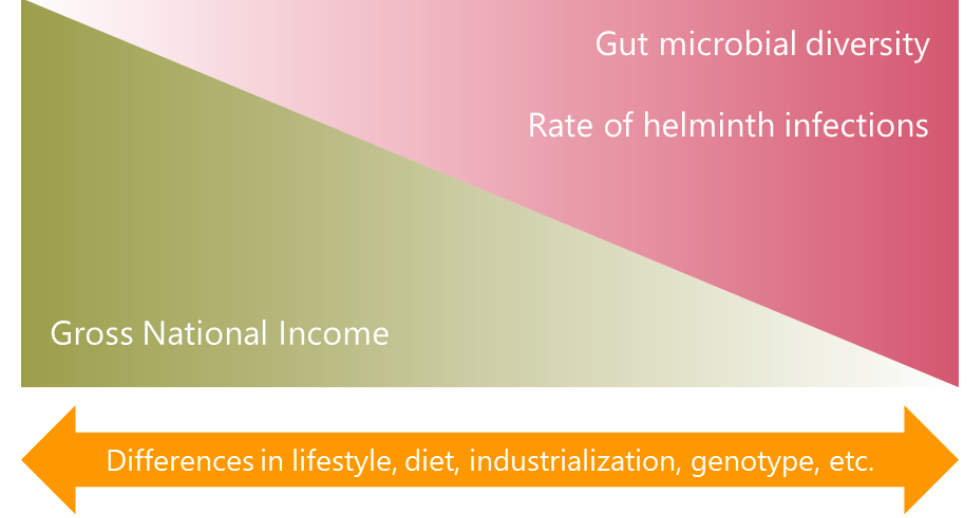
Figure 1. National income and diversity of the gut microbiota. The higher diversity of the intestinal bacterial communities among populations from LMICs coincides with a high rate of soil-transmitted helminth infections in those countries, suggesting that parasites could be involved in these findings together with other factors.